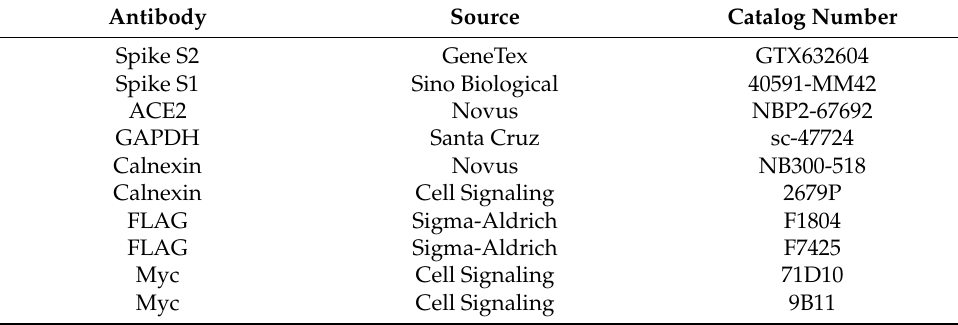
Table 2. Primary antibodies